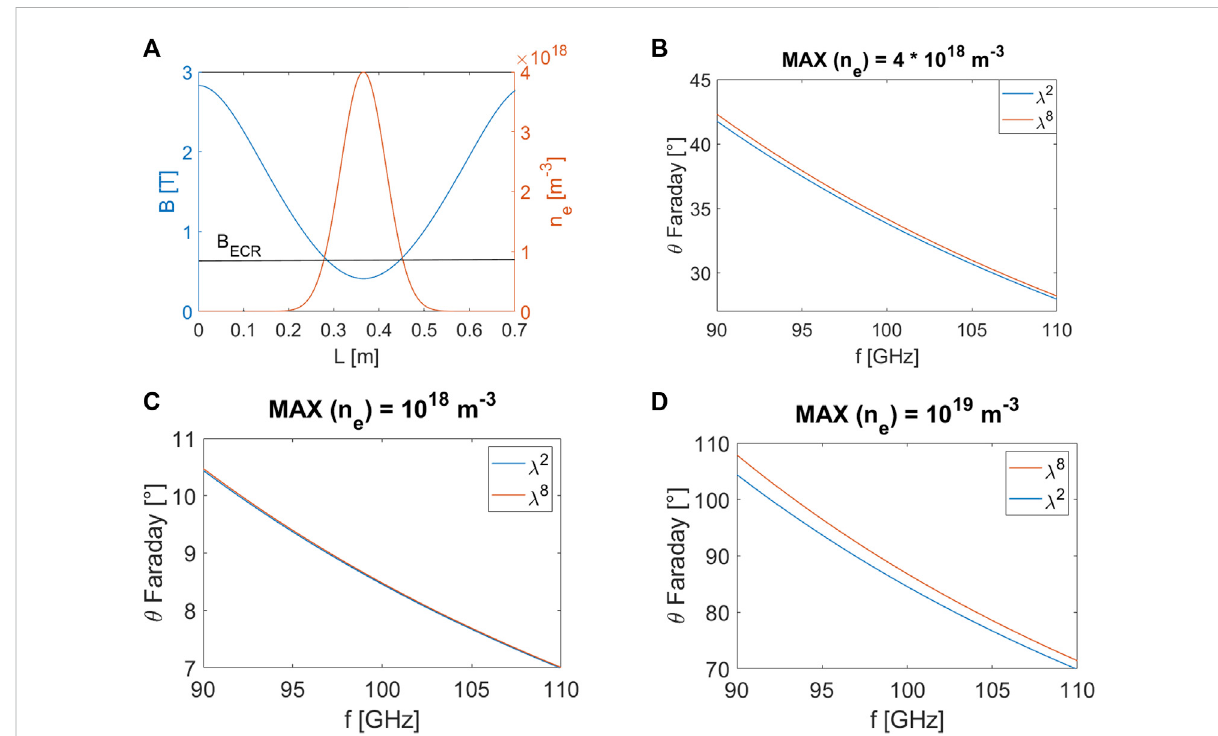
FIGURE 3 (A) Magnetic fi eld (blue) and electron density (red) pro fi les on the longitudinal z-axis of the PANDORA plasma chamber, considered for the Faradayrotationangleestimation. (B) Faradayrotationangle θ Faraday vs.probingfrequency f consideringaGaussiandensitypro fi lehavingamaximum value n 0 = 4 · 10 18 m − 3 . (C) The same of (B) at a maximum value n 0 = 10 18 m − 3 . (D) The same of (B) at a maximum value n 0 = 10 19 m − 3